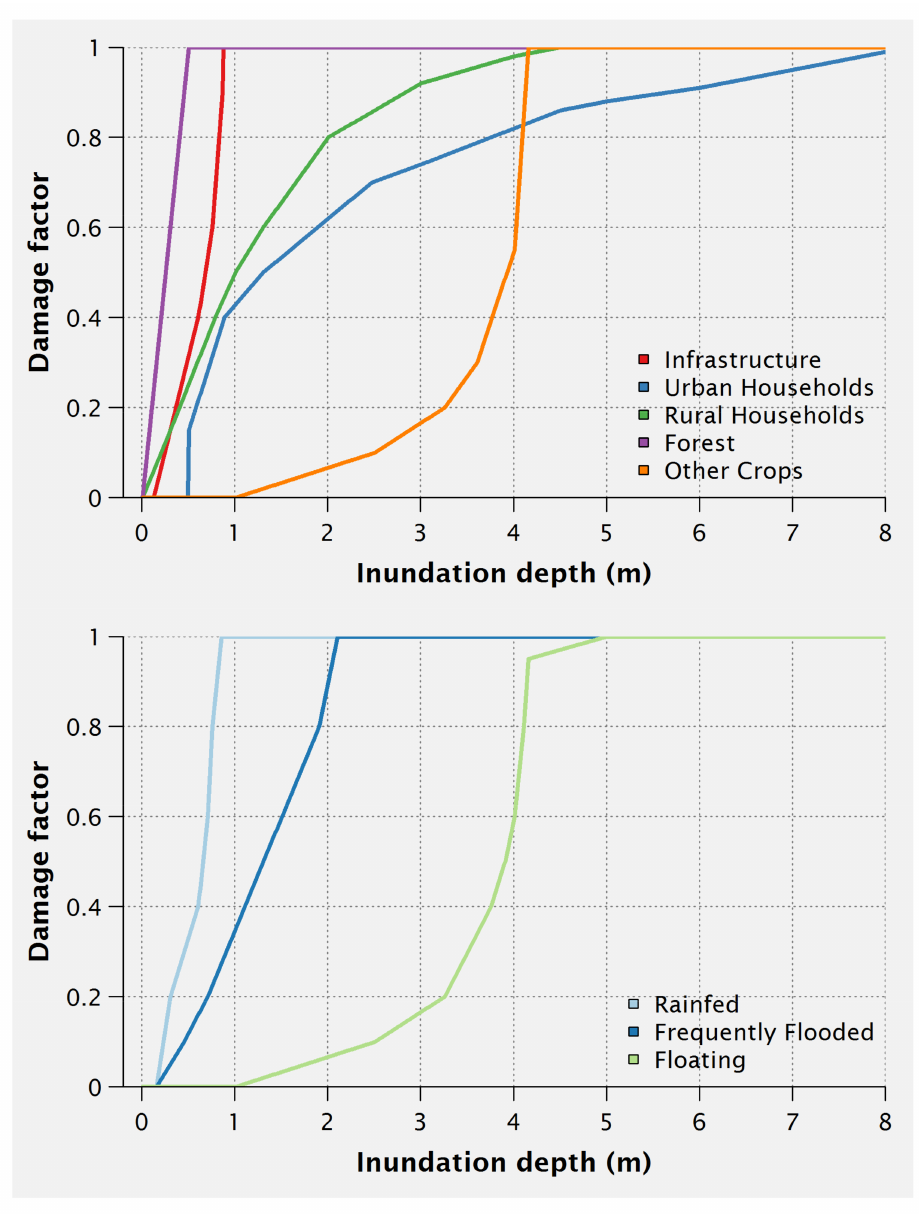
Figure 5. Damage factor curves for agriculture, forest, and infrastructure classes ( upper ) and rice varieties ( lower ) found in the Lower Mekong Basins (LMB). Curves digitized and adapted from Chen (2007)